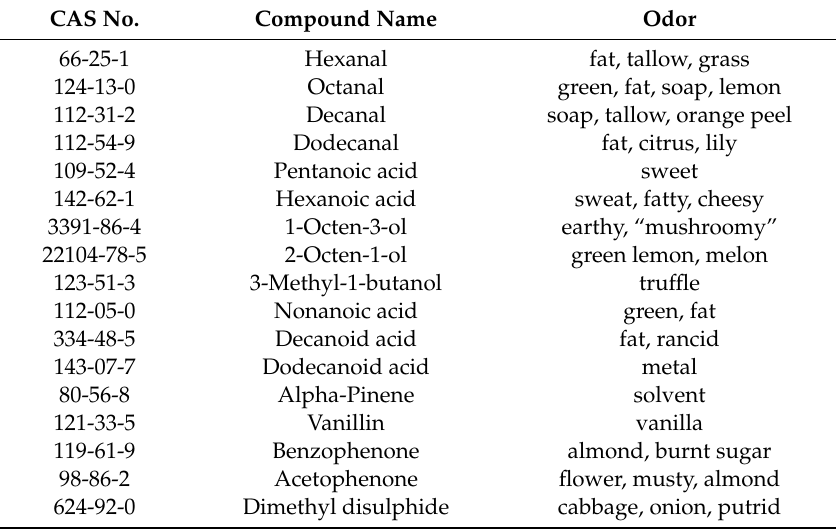
Table 2. List of MVOCs with types of odors for some identified compounds [8,22]. CAS No. Compound Name